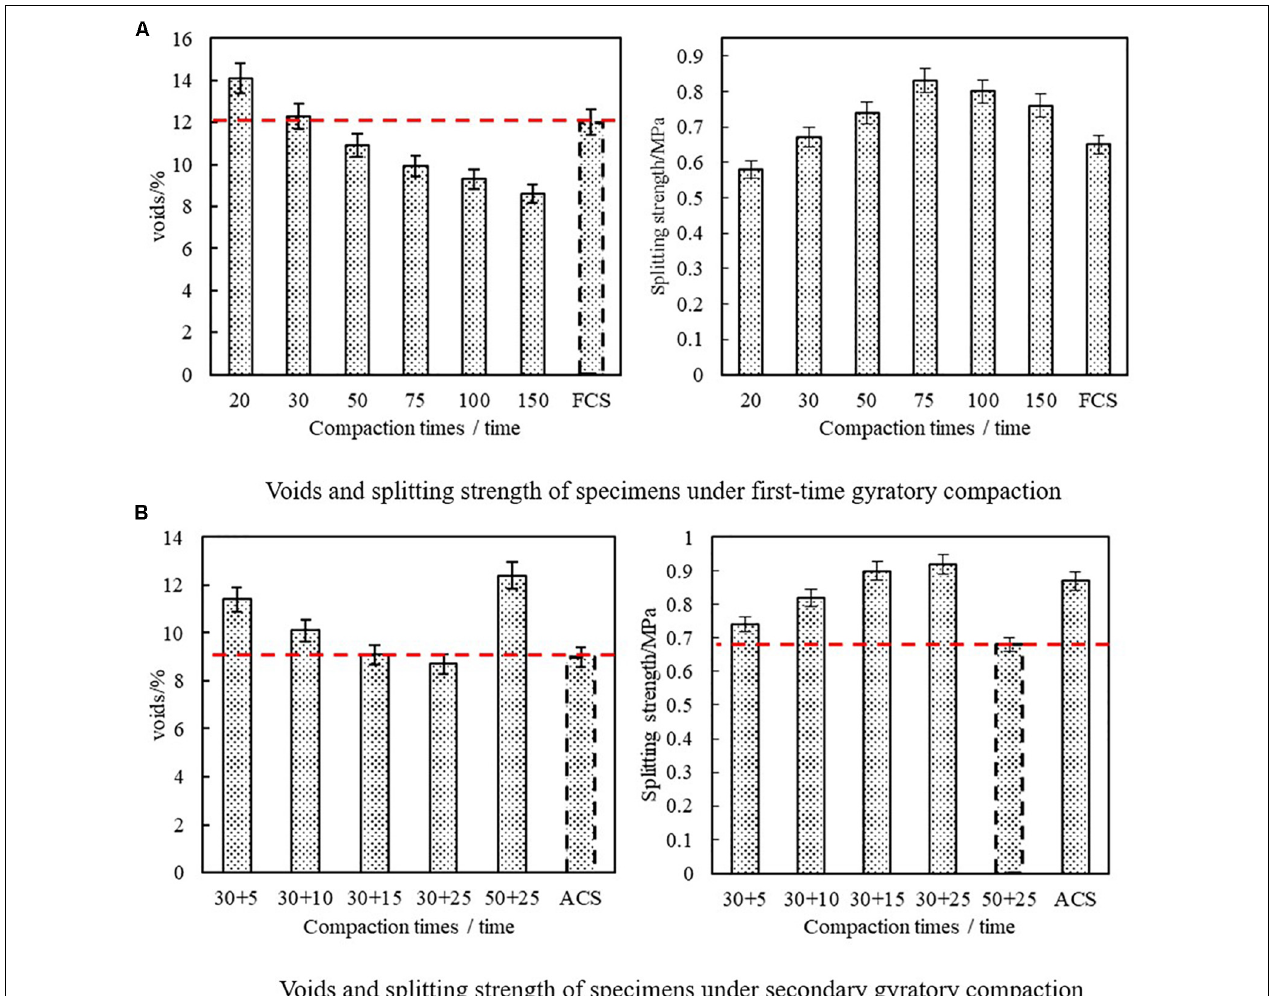
FIGURE 5 | Voids and splitting strength of specimens under different times of gyratory compaction: (A) voids and splitting strength of specimens under first-time gyratory compaction; (B) voids and splitting strength of specimens under secondary gyratory compaction.